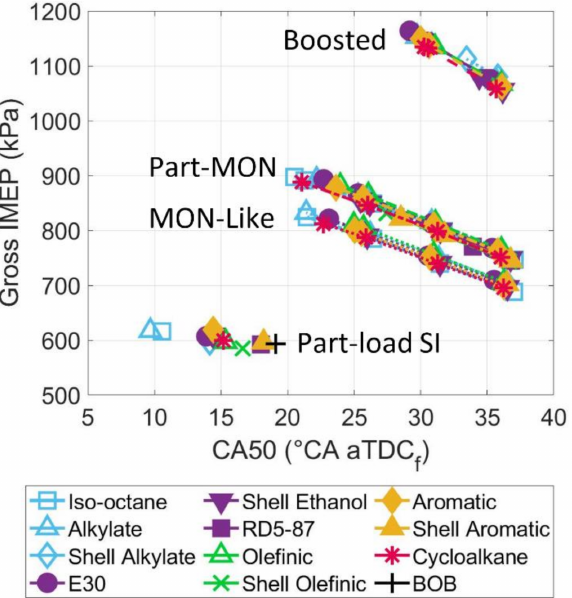
Figure 2. Gross IMEP as a function of the CA50 combustion phasing for each of the four SI operat- ing